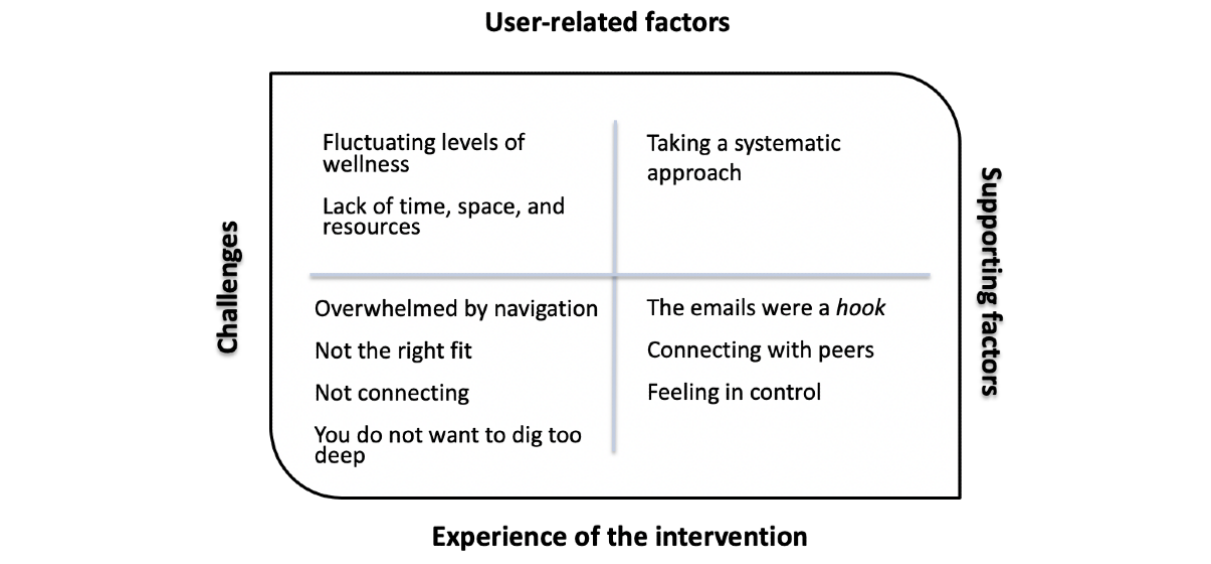
Figure 2. Challenges to engagement and factors supporting persistence with the